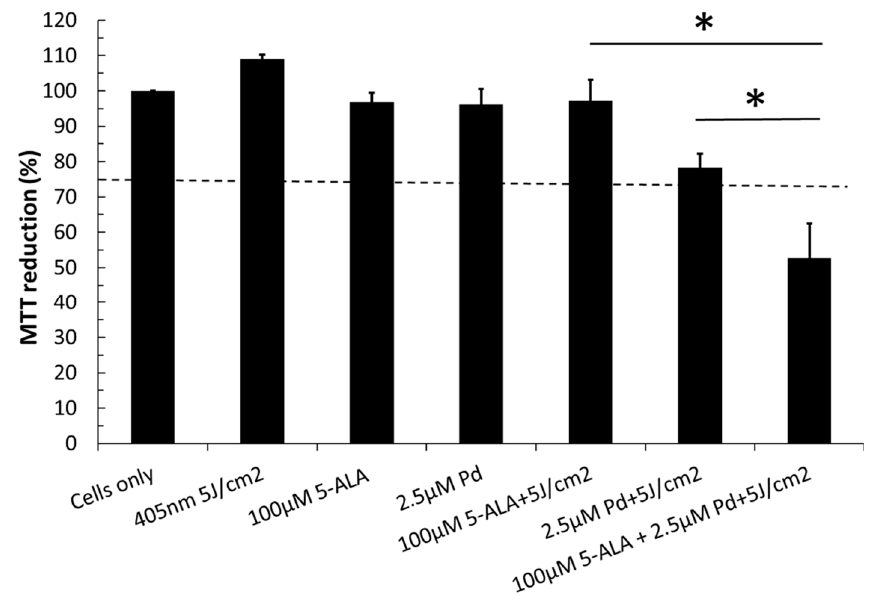
Figure 3. Combinatorial effects of 5-ALA and Pd(T4) on photodynamic lysis. Melanoma cells were subjected to treatment with porphyrins 5-ALA, Pd(T4), or both. Cells were grown to 90–100% confluency then incubated with either a photosensitizer or with 5-ALA ten minutes before Pd(T4). After a 2 h incubation, cells were irradiated with 5 J / cm 2 of 405 nm LEDs. Viability was tested using MTT assay 24 h post-PDT and determined by the percent of MTT reduction, which in turn is determined by dividing the absorbance of treatment groups over cells alone. Data represents average + standard deviation of duplicate wells from three independent experiments using a one-way ANOVA with Tukey’s multiple comparison test. Statistical di ff erences between single treatment and combinatorial treatments were represented by * p < 0.005. The dotted line represents where a cumulative e ff ect between 5-ALA and Pd(T4) would exist.